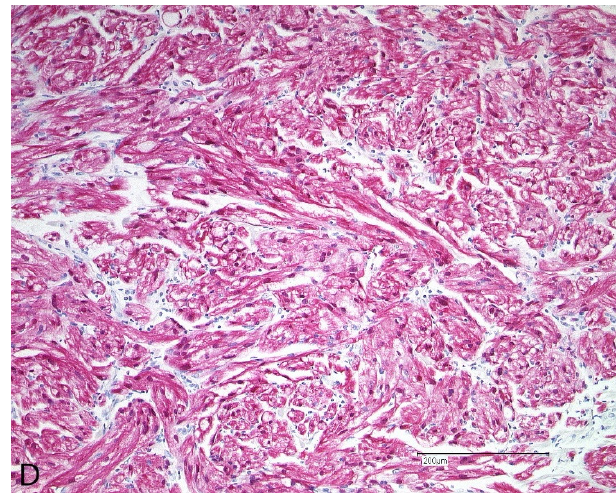
Figure 5. Histological findings: The granular appearance of the cytoplasm as to be seen at higher magnification is the typical morphological feature of GCT. H/E ‐ staining, scale bars 500 μ m ( A ), zoomed ‐ in views 100 μ m ( B ) and 20 μ m ( C ). The tumor consists of aggregates of granular cells staining intensively positive for S100 (( D ) : immunohistology for S ‐ 100). Granular cell infiltration and disruption of the nerval structures can be seen on both H/E ‐ staining and after S ‐ 100 staining.